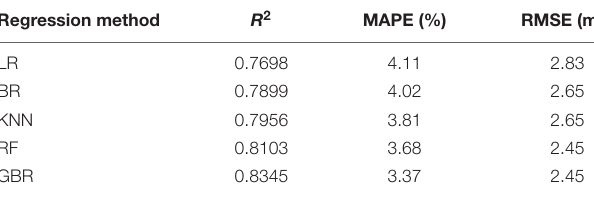
TABLE 4 | The performance of grain weight prediction